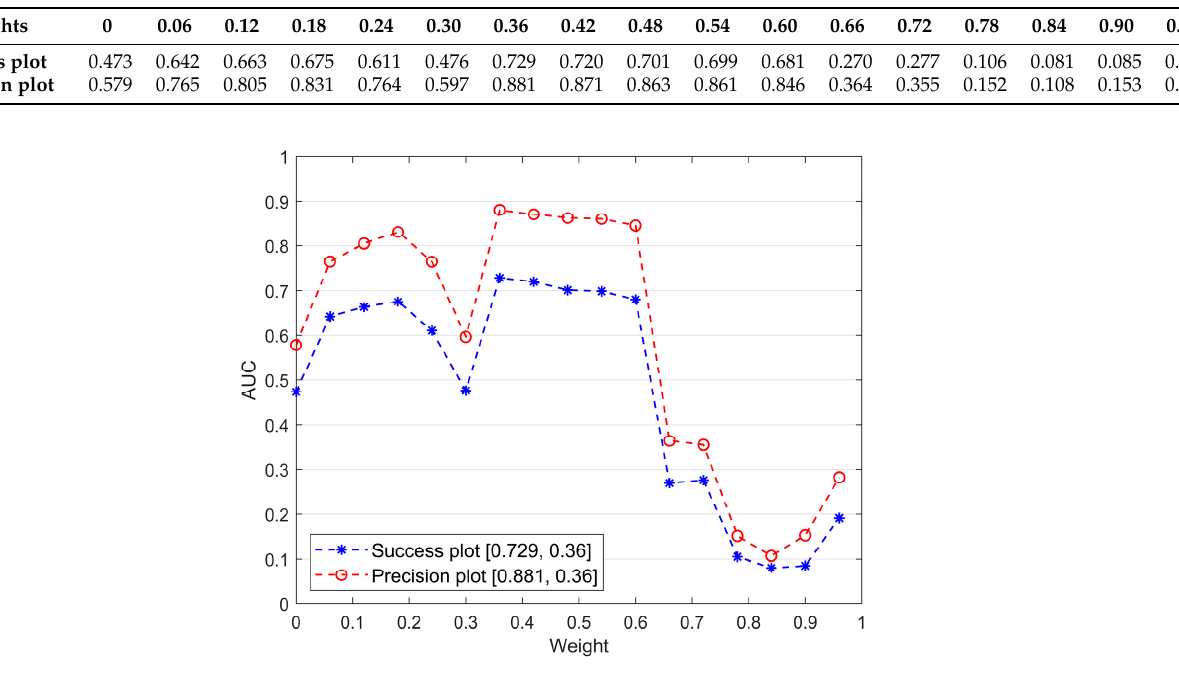
Table 3. Components and results of ablation